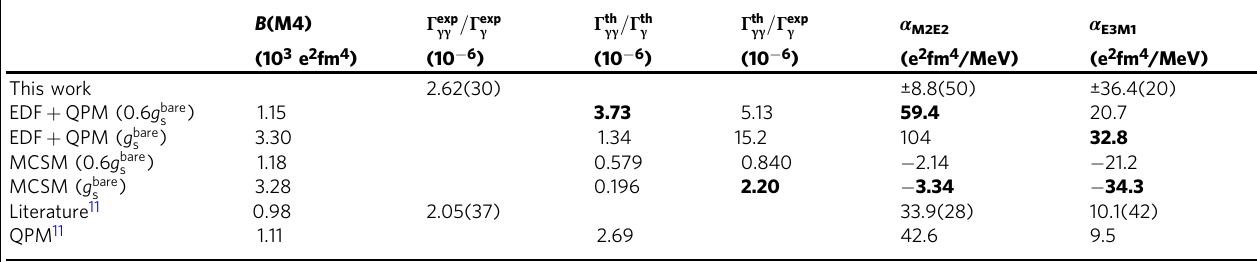
Table 1 Experimental and calculated α coef fi cients and γγ / γ decay branching ratios.